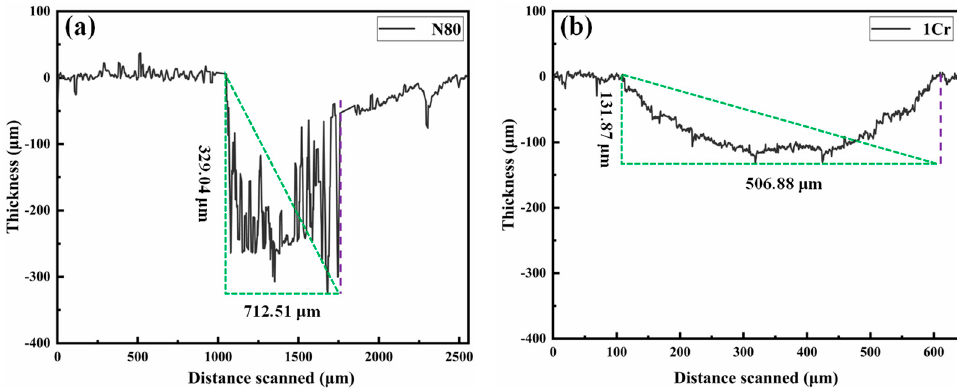
Figure 9. The maximum Pit size measurement and evaluation along the cross-sections:( a ) cross- sections A-A (N80); ( b ) cross-section B-B (1Cr) under the condition of 50 ◦ C-CO 2 : 0.30 MPa.